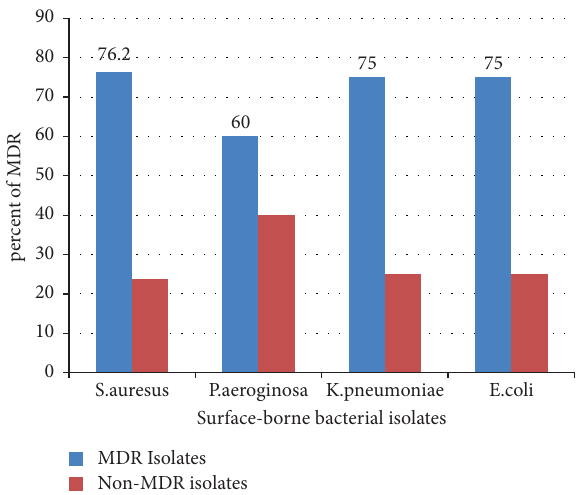
Figure 4: Surface-borne multidrug resistant bacterial isolates at WSUCH, Wolaita Sodo, Ethiopia,